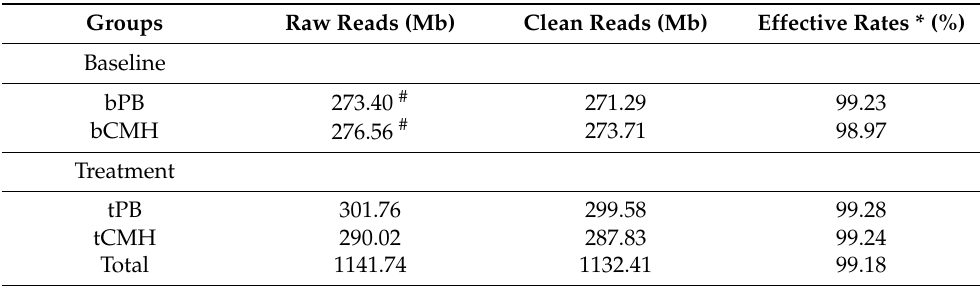
Table 1. Summary of WMGS datasets for each group.